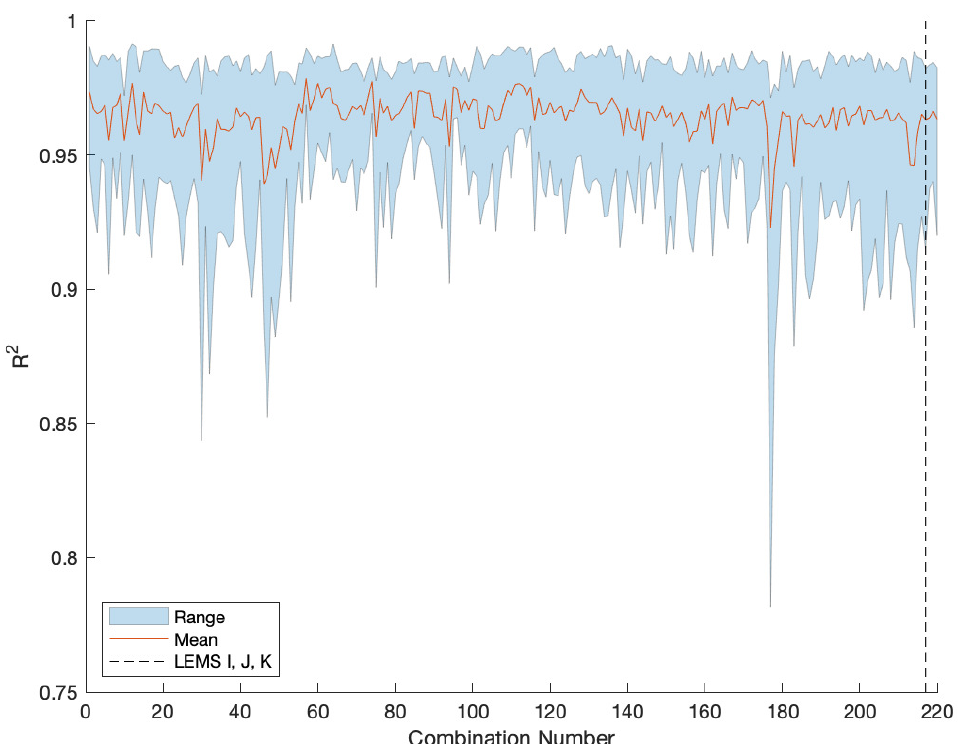
Figure A4. Example of combinatorial analysis for the virtual potential temperature predictions from MLR for 15 January 2017 through 20 January 2017. For every combination of three input and nine output LEMSs, the minimum, maximum, and mean R 2 value was calculated. The range of the R 2 values are shown in light blue and the mean R 2 value is shown in red. As is evident from the plot, all combinations of input LEMSs perform similarly. We use these statistics because they are a good way to summarize multiple time